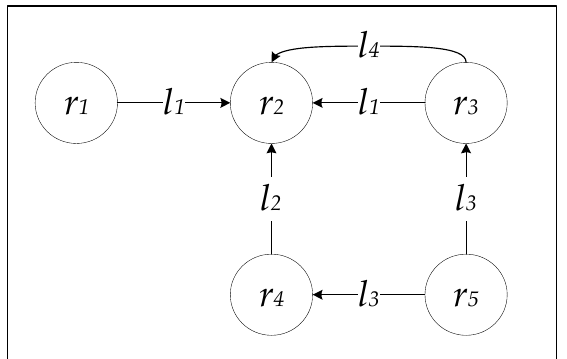
Figure 2. Sample Linked Open Data (LOD) graph.